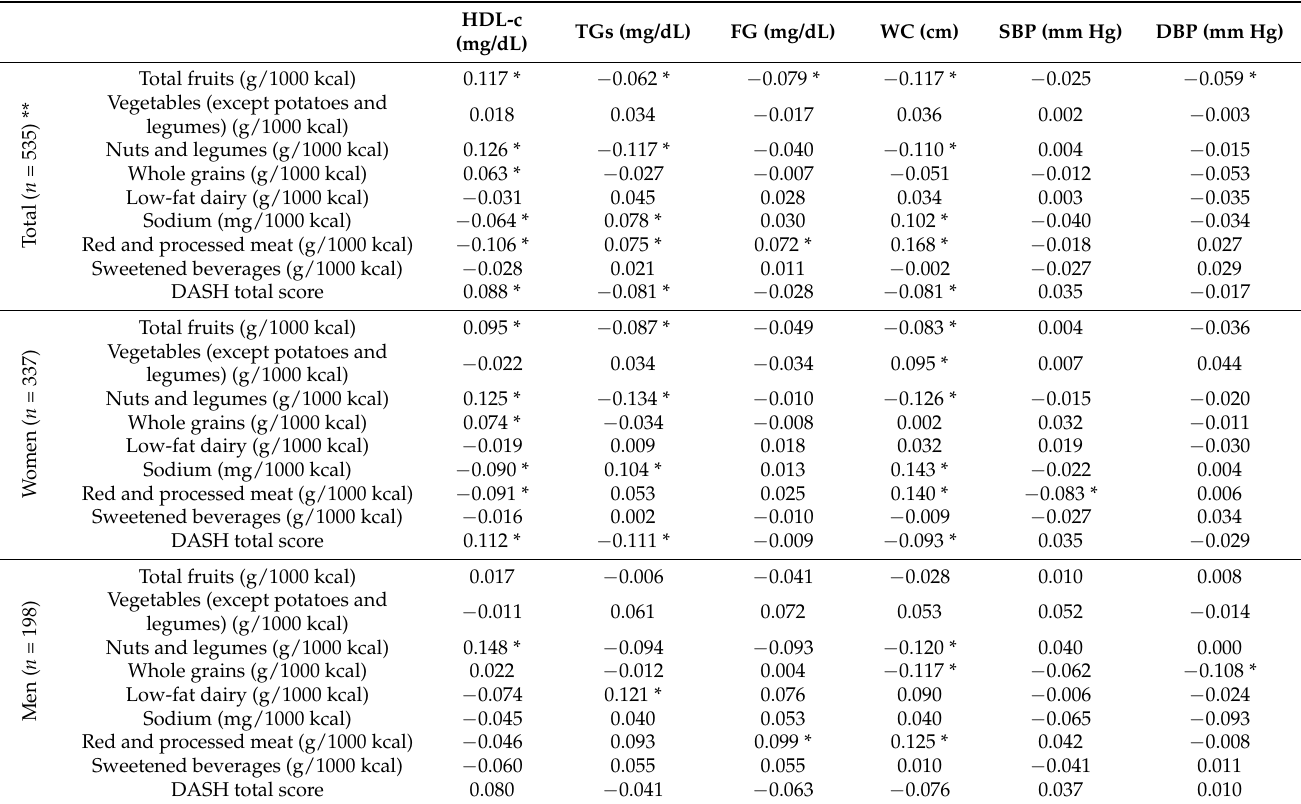
Table 5. Tau Kendall correlations between DASH components, total DASH score, and metabolic syndrome